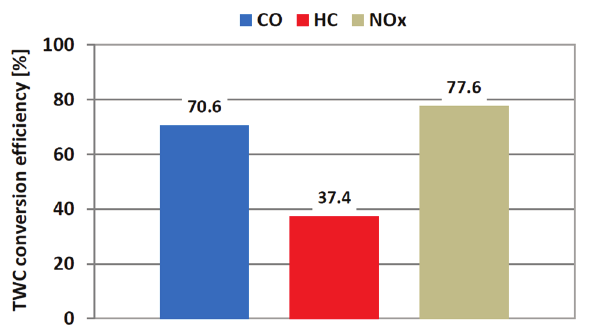
Fig. 12. Conversion efficiency of TWC during operation of the engine with stoichiometric air-fuel